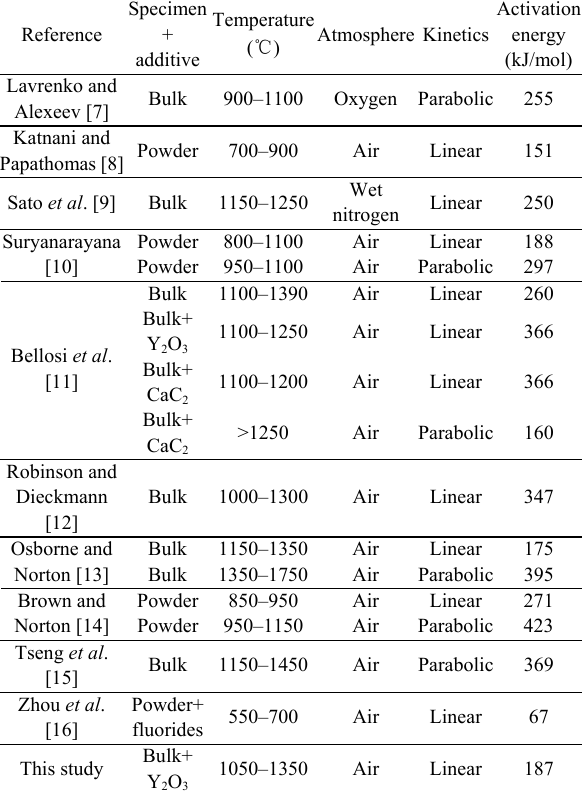
Table 1 Previous results for the oxidation of aluminum